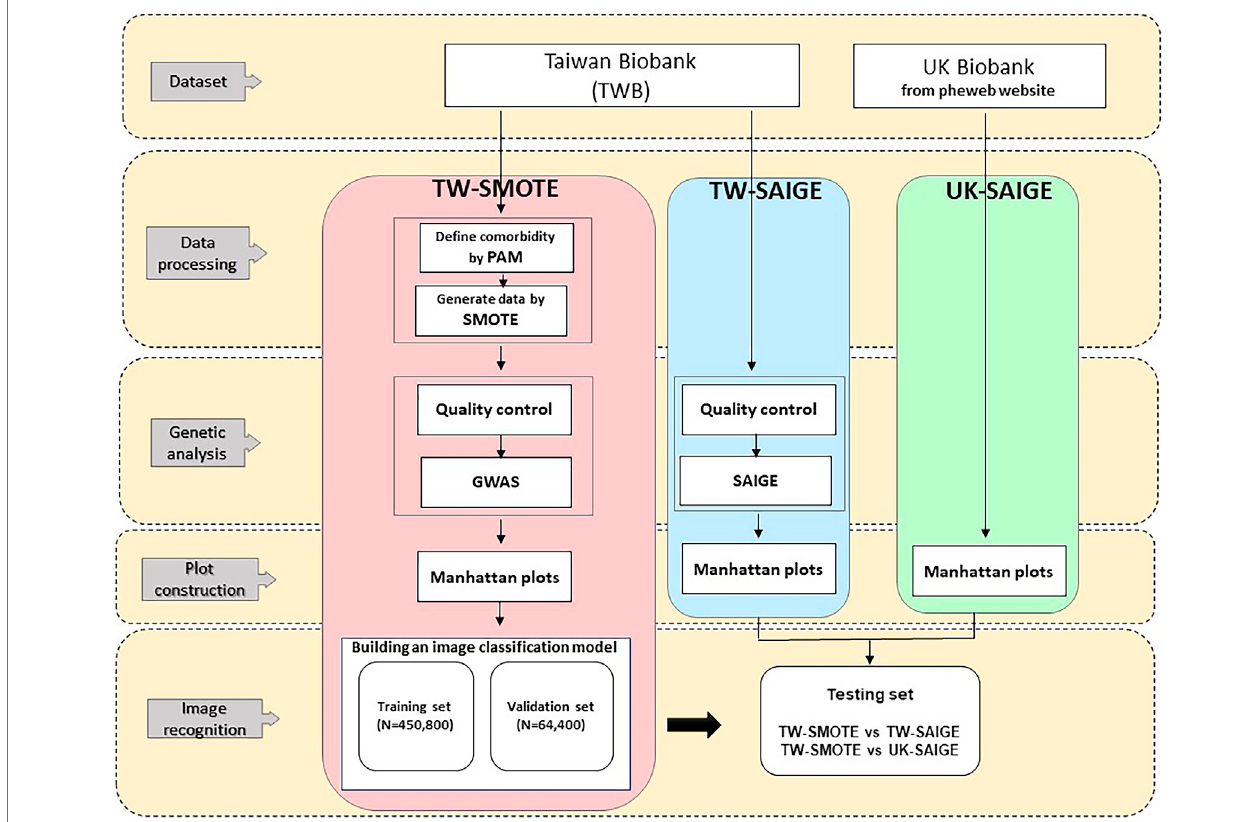
FIGURE 1 | Analysis fl ow of this